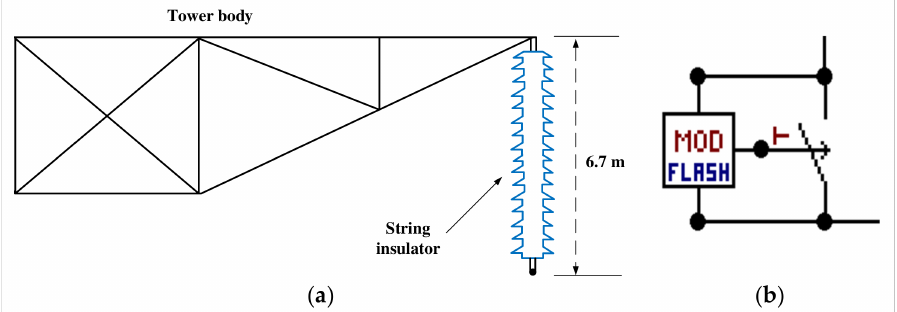
Figure 6. ( a ) Suspension-type glass insulator string of 500 kV DC-TL; ( b ) model of tower insulator string in